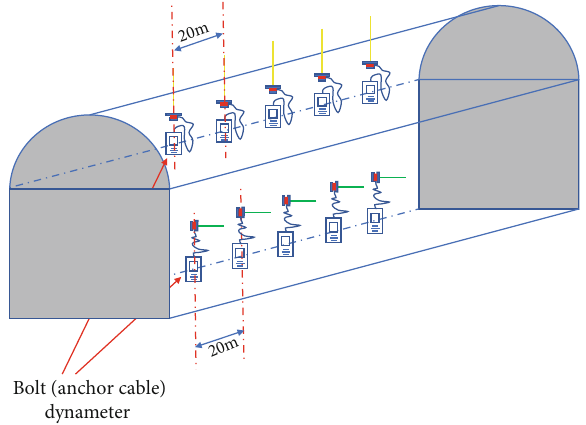
Figure 3: Layout of bolt (anchor cable) dynameter along the